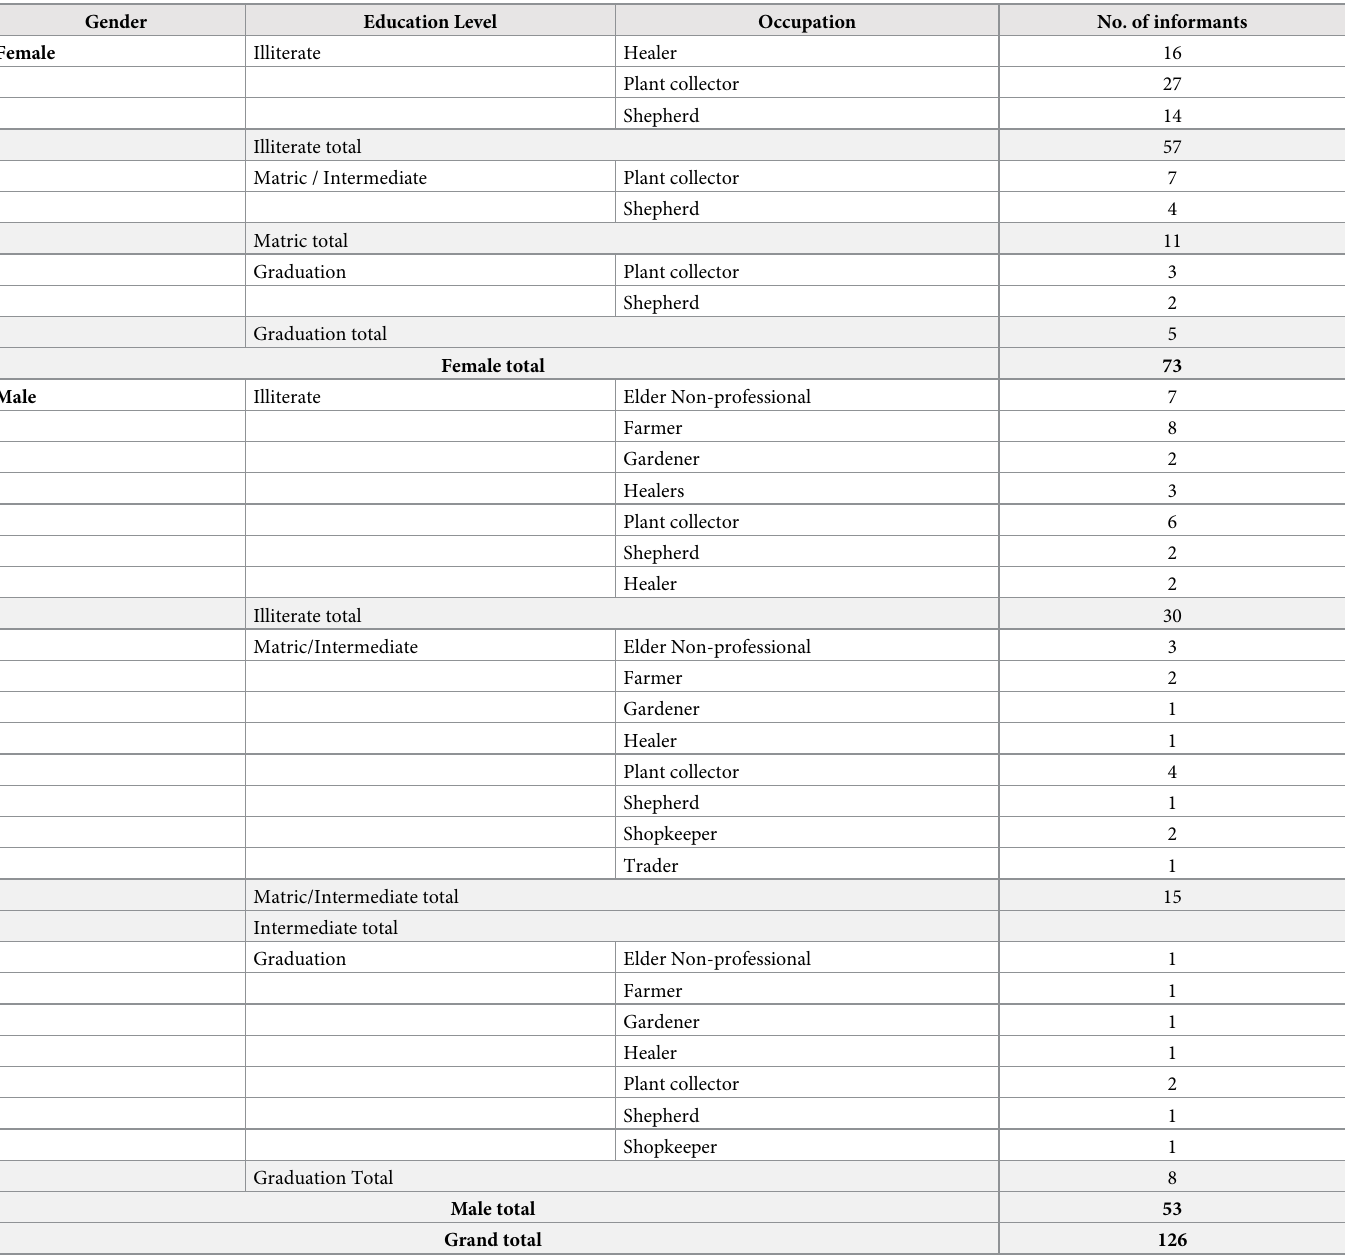
Table 1. Informant’s demographics in the study